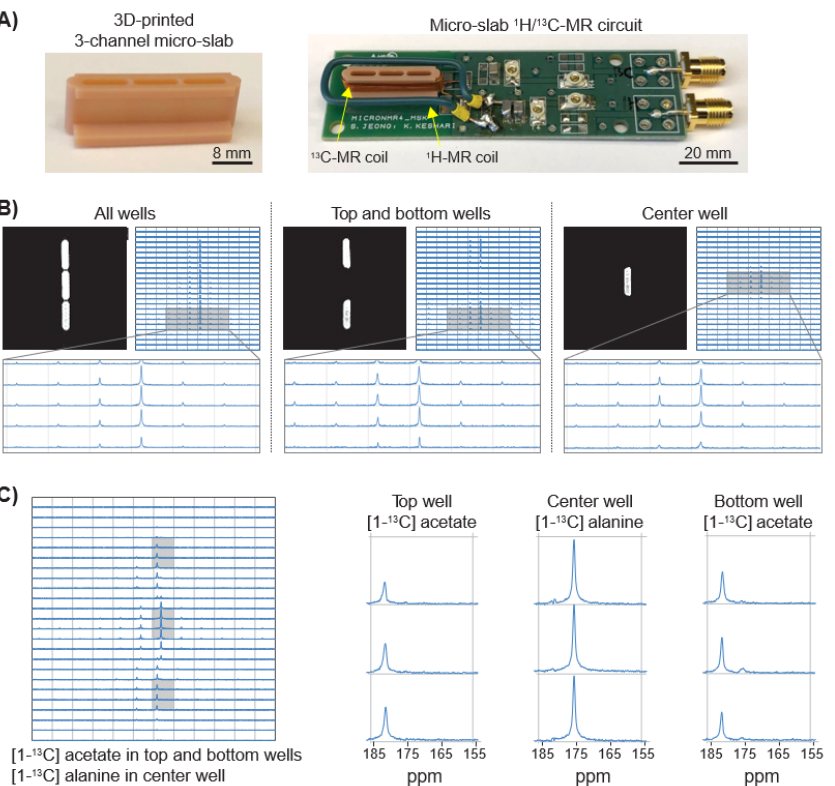
Figure 2. Multi-channel micro-slab MR coil analyzes different samples simultaneously. ( A ) Optical picture of the system. A 3-channel micro-slab construct was made with a 3D printer (Left). A 28- gauge magnetic wire was wound around the micro-slab construct and connected to 13 C-MR circuit in a custom-designed 1 H/ 13 C-MR circuit board (Right). A single-loop coil was connected to 1 H-MR circuit. ( B ) Three sets of a T 2 -weighted MR image and an array of 2D-CSI 13 C-MR spectra acquired when 4 M [1- 13 C] sodium acetate solution was loaded into wells accordingly. ( C ) 2D-CSI 13 C-MR spectra acquired when 4 M [1- 13 C] acetate solution was loaded into the top and bottom wells and 8 M [1- 13 C] alanine solution was loaded into the center